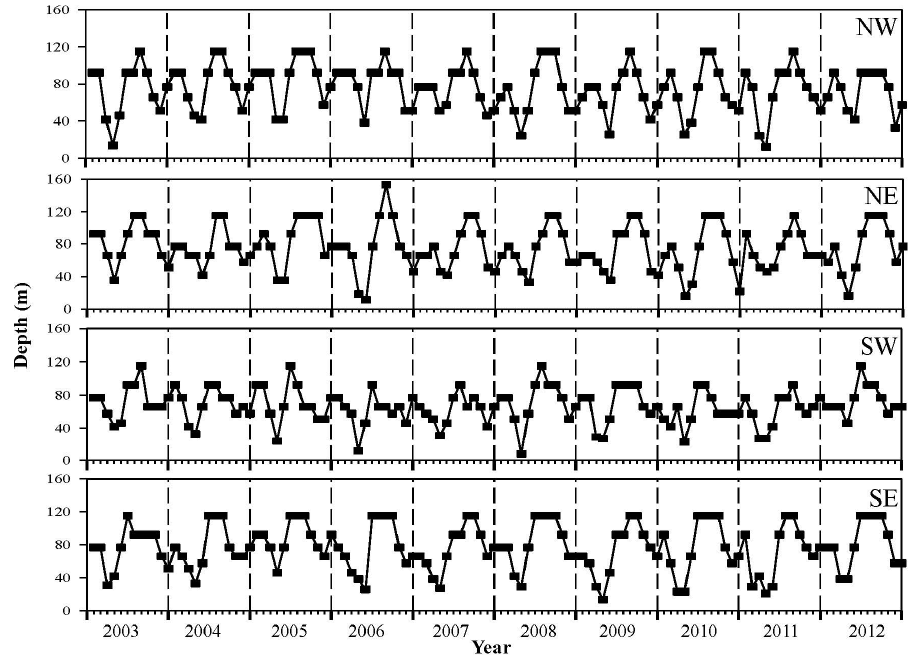
Figure 2. Monthly variability of euphotic depths for the four sub-research areas in the East Sea from January 2003 to December 2012. January 2003 to December